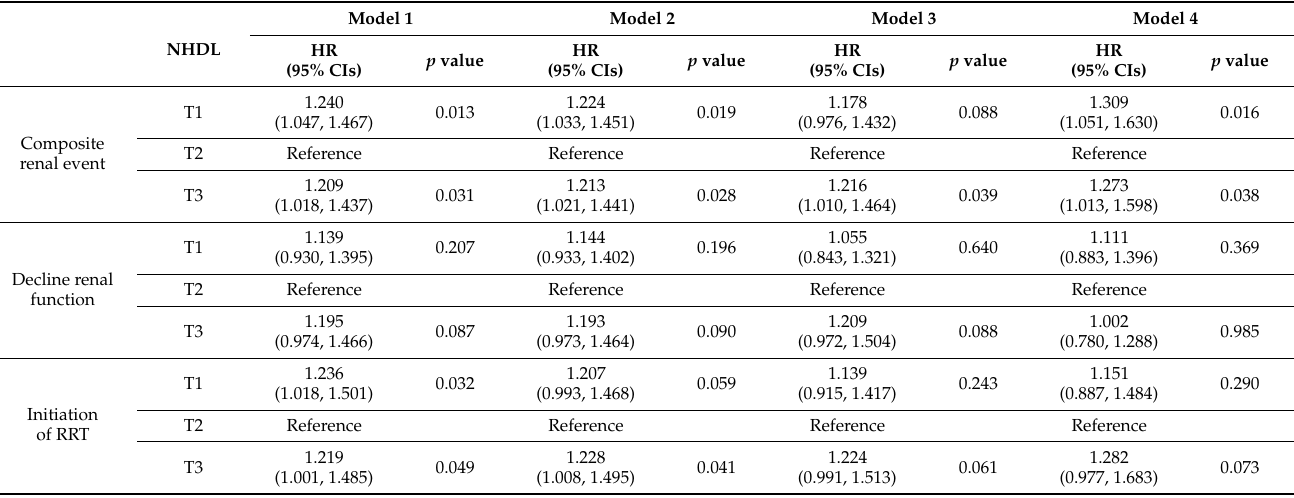
Table 4. Cause-specific HRs for the study outcomes by nHDL